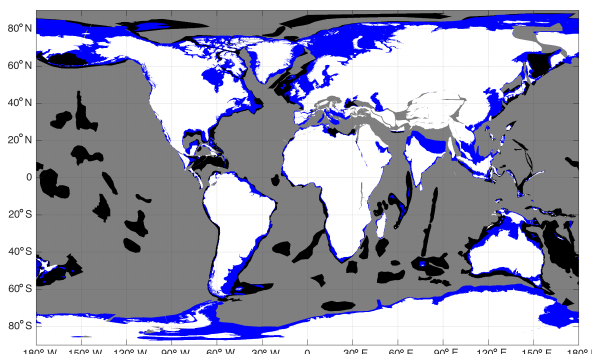
Figure 1. Earth reconstruction from the plate tectonic model at 38Ma showing shifted present-day land surface (white), continen- tal shelves (blue) and relatively shallow ocean regions (black). Re- maining in grey are then the deep ocean and zones that are yet unidentified in the plate-tectonic reconstruction model.